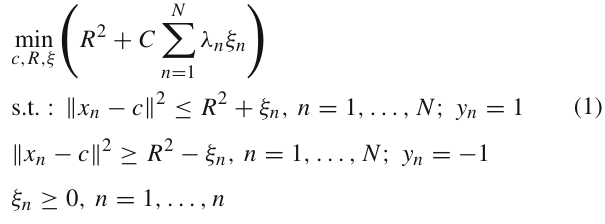
Fig. 1 Graphical model of a mixture of